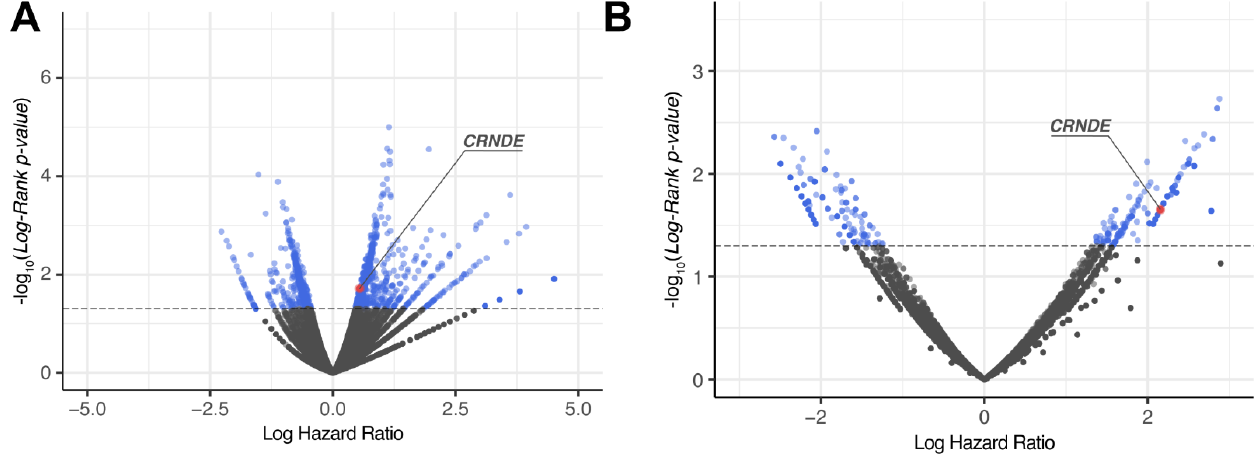
Figure 3. Distribution of differential genes by log-rank p -value and log hazard ratio for progression-free survival (PFS) data across: ( A ) TCGA and ( B ) Slovenia glioblastoma datasets.